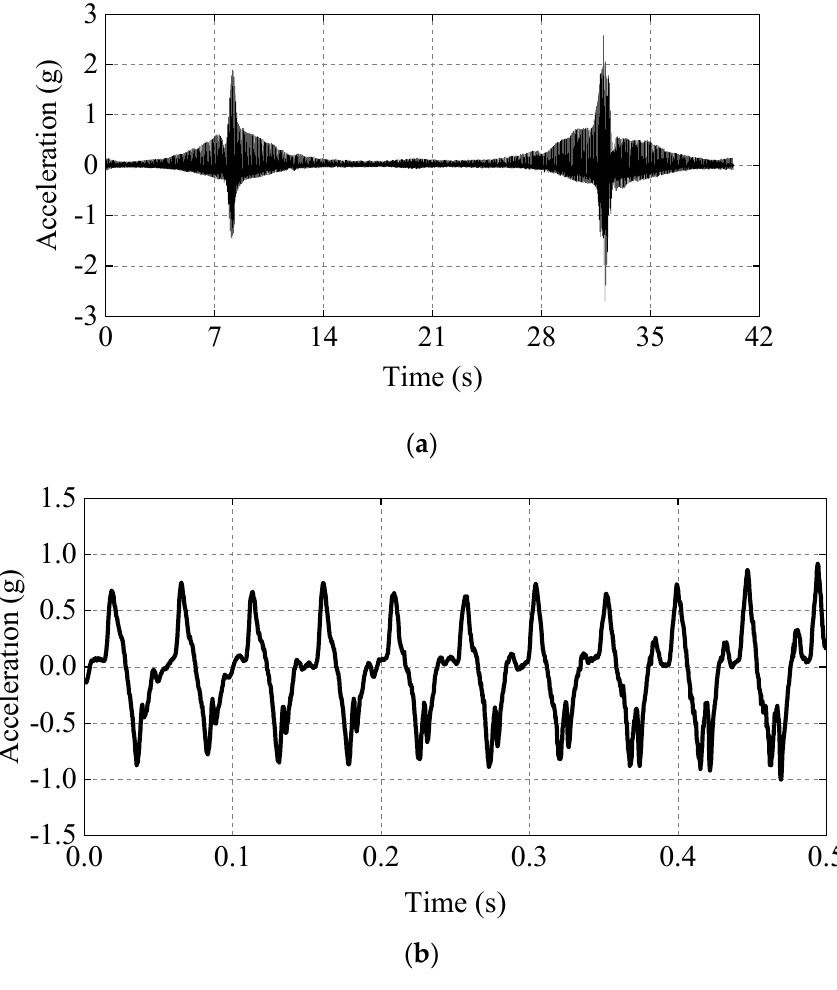
Figure 4. Time − history curve of acceleration. ( a ) Acceleration time − history curve in Z − direction (The whole time period). ( b ) Acceleration time − history curve in Z-direction (The partial time period).